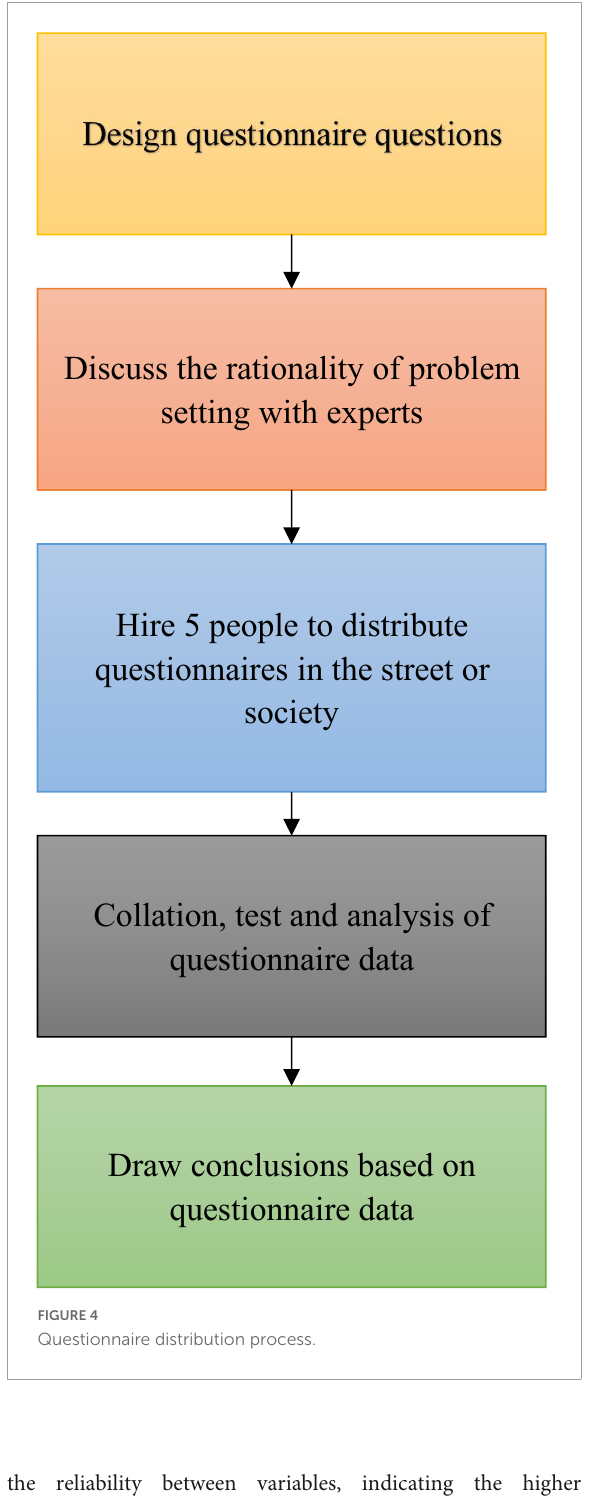
the reliability between variables, indicating the higher internal consistency between variables. The above equation is used to test the reliability of the internal consistency of the answers to the questionnaire, and the calculated result is 0.86, indicating that the questionnaire has a high reliability.